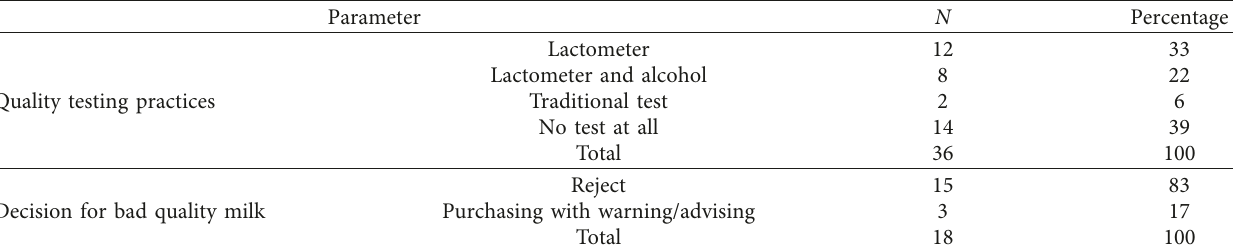
Figure 4: Milk procurement strategies in Ziway-Hawassa milk shed. Table 4: Quality testing practices and decisions for bad milk